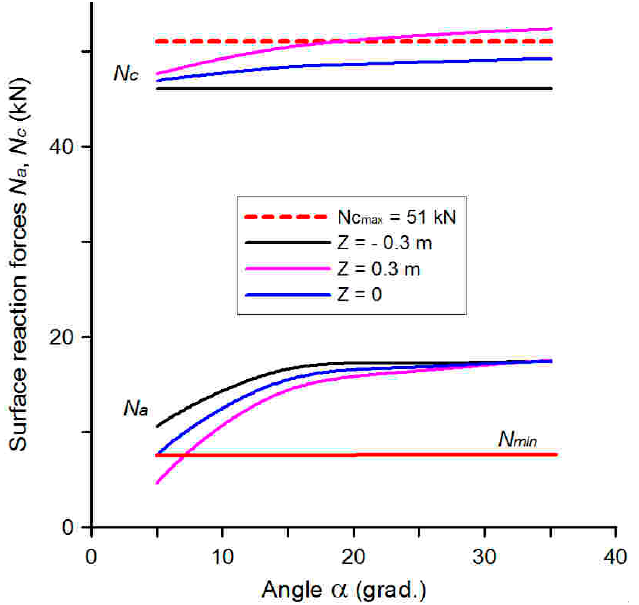
α of the central link of the